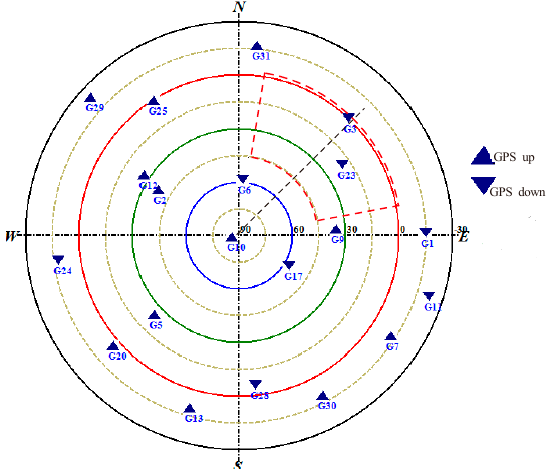
Figure 2. Sky view of Global Positioning System (GPS) satellites related to the experimental site (31.6°N, 119°E) at 21:54 on 3 June 2015 and receiving area of the dual-polarized antenna (enclosed by red dashed line).